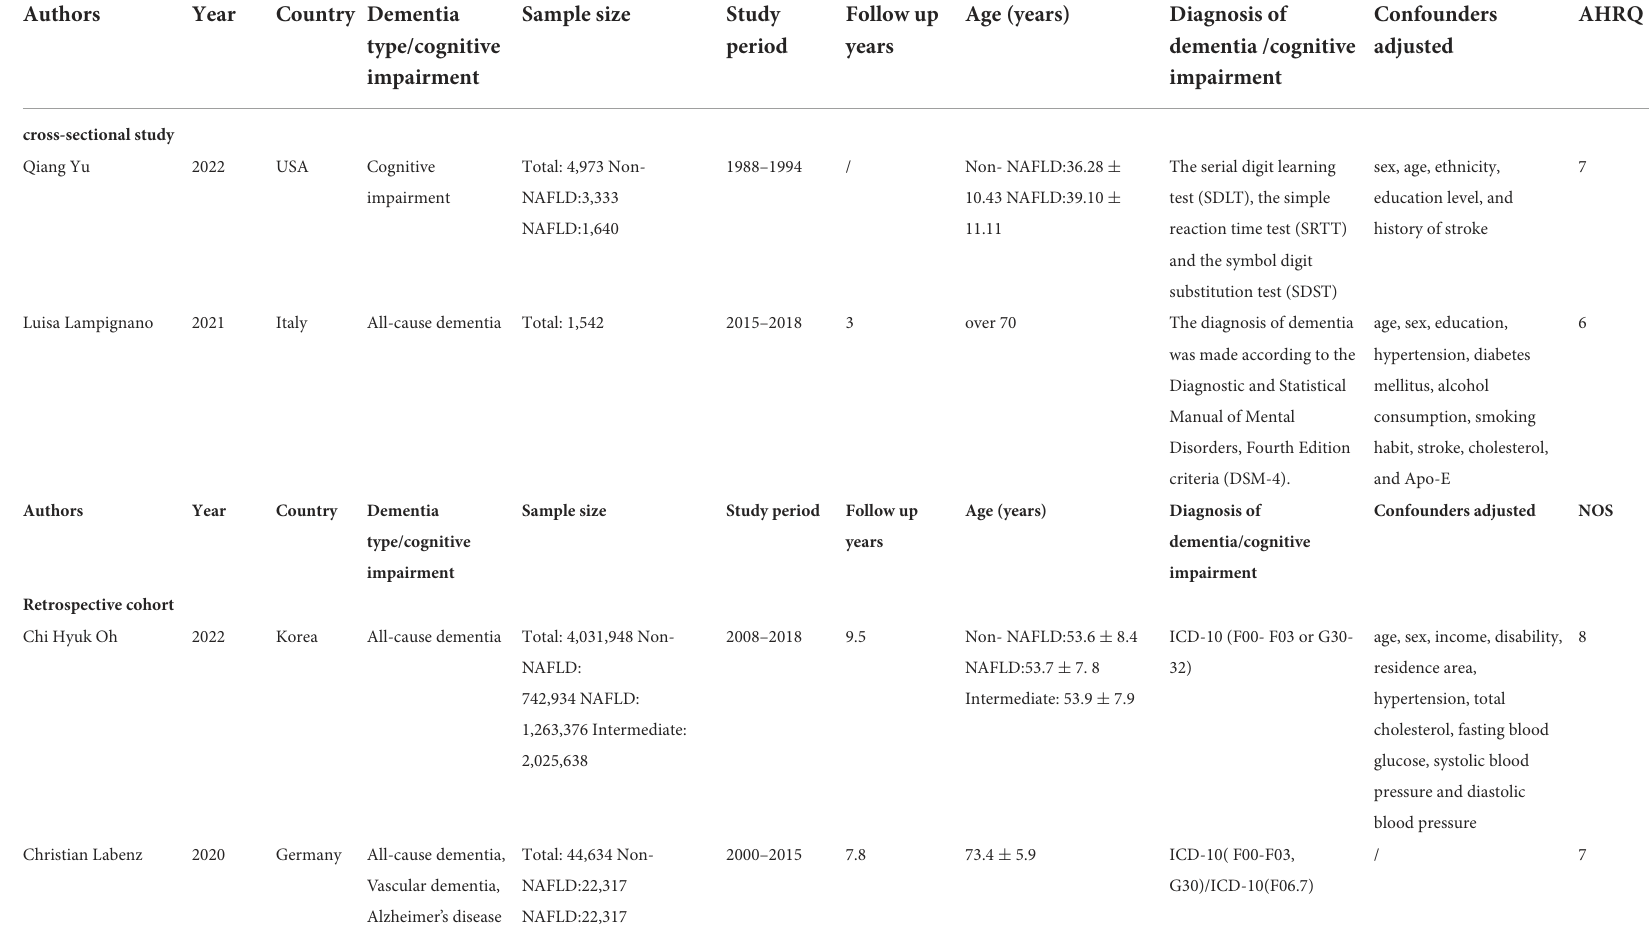
TABLE 1 Characteristics of studies included in the